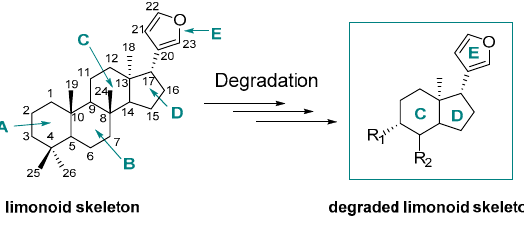
Figure 2. Limonoid and degraded limonoid skeleta.